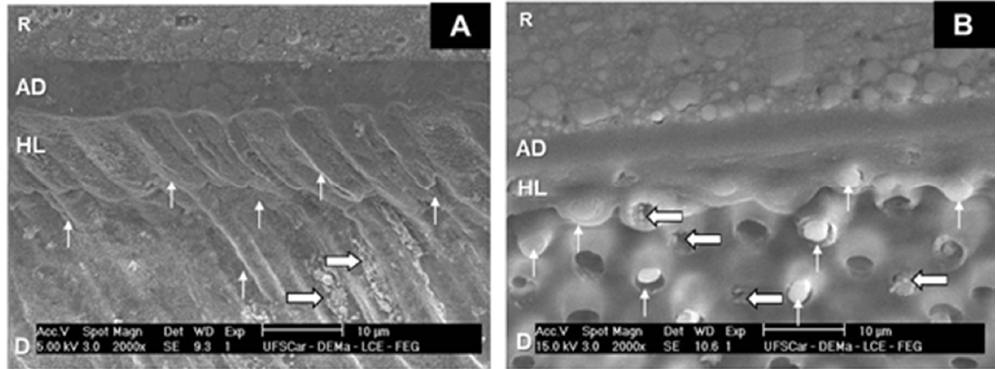
Figure 1. SEM micrographs of Group 1. ( A ) 2000×. Note the hybrid layer (HL) at the dentin (D)/adhesive (AD)/composite resin (R) interface, with resinous tags (thin arrows). Thick arrows indicate the deposition of biosilicate microparticles in dentin tubules. ( B ) 2000×. Hybrid layer (HL) at the dentin (D)/adhesive (AD)/composite resin (R) interface; thin arrows: resinous tags; thick arrows: biosilicate microparticles in dentin tubules.